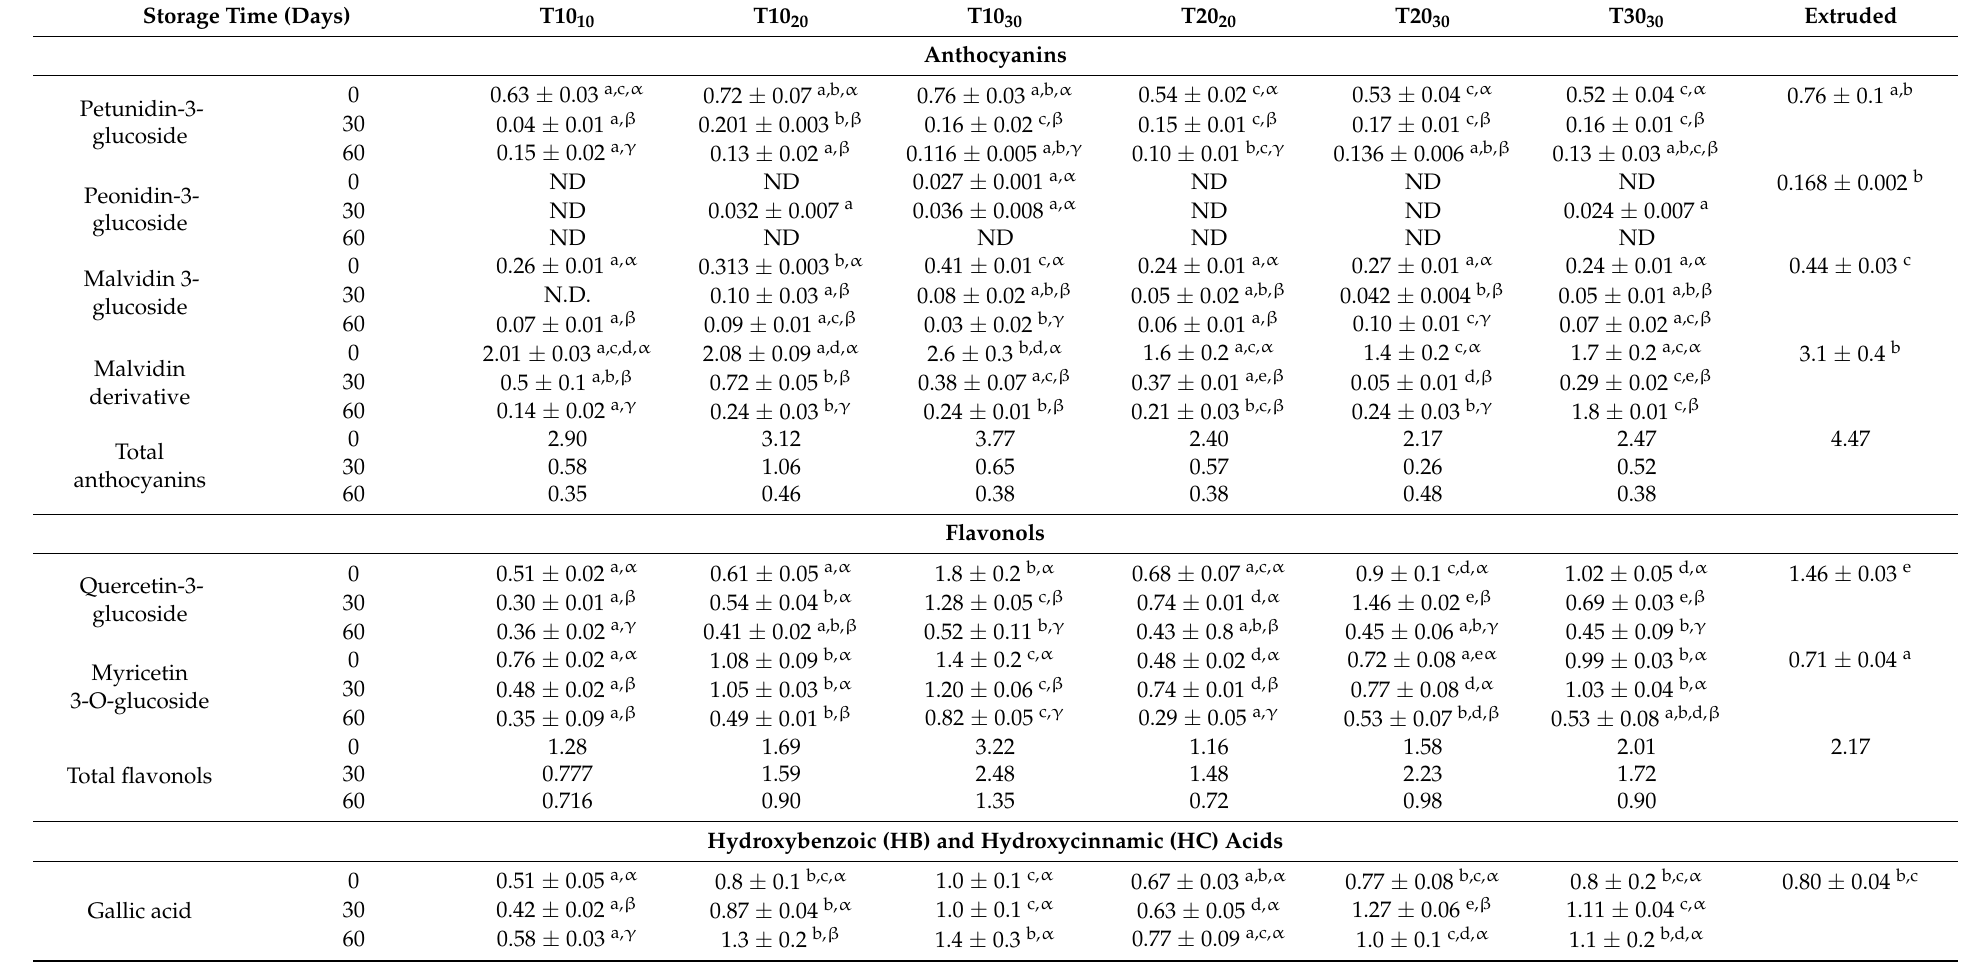
Table 2. Phenolic compounds (mg/L) in grape juices at different initial extraction times, measured by HPLC, before and after 30 and 60 days of